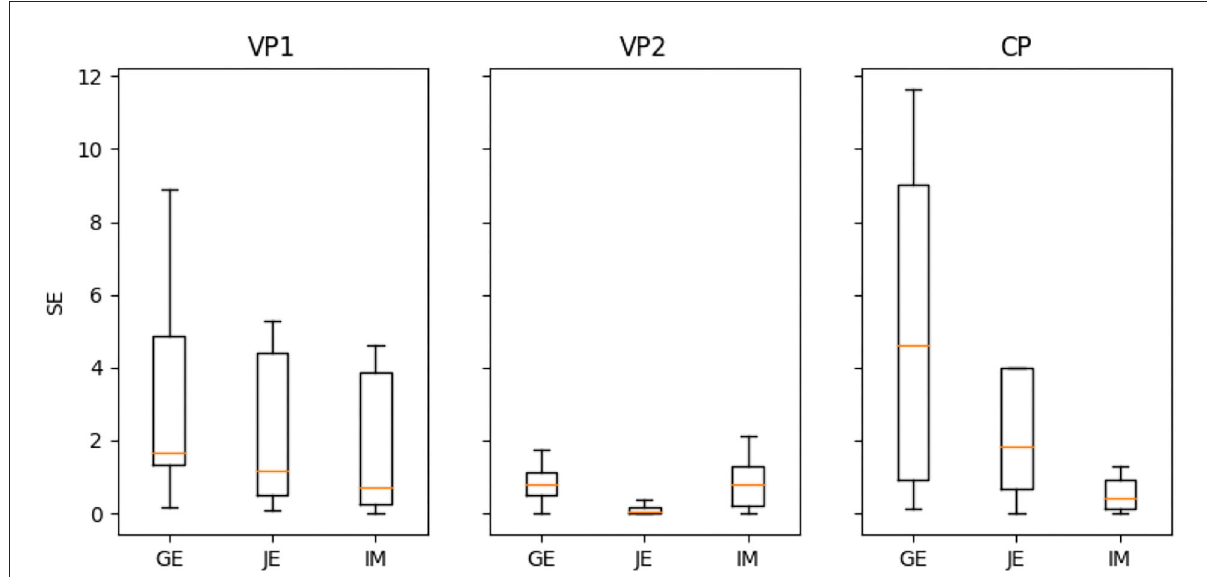
FIGURE6 Comparison of the predictive power (due to square error SE) for variable practice (VP1 and VP2) and constant practice (CP)